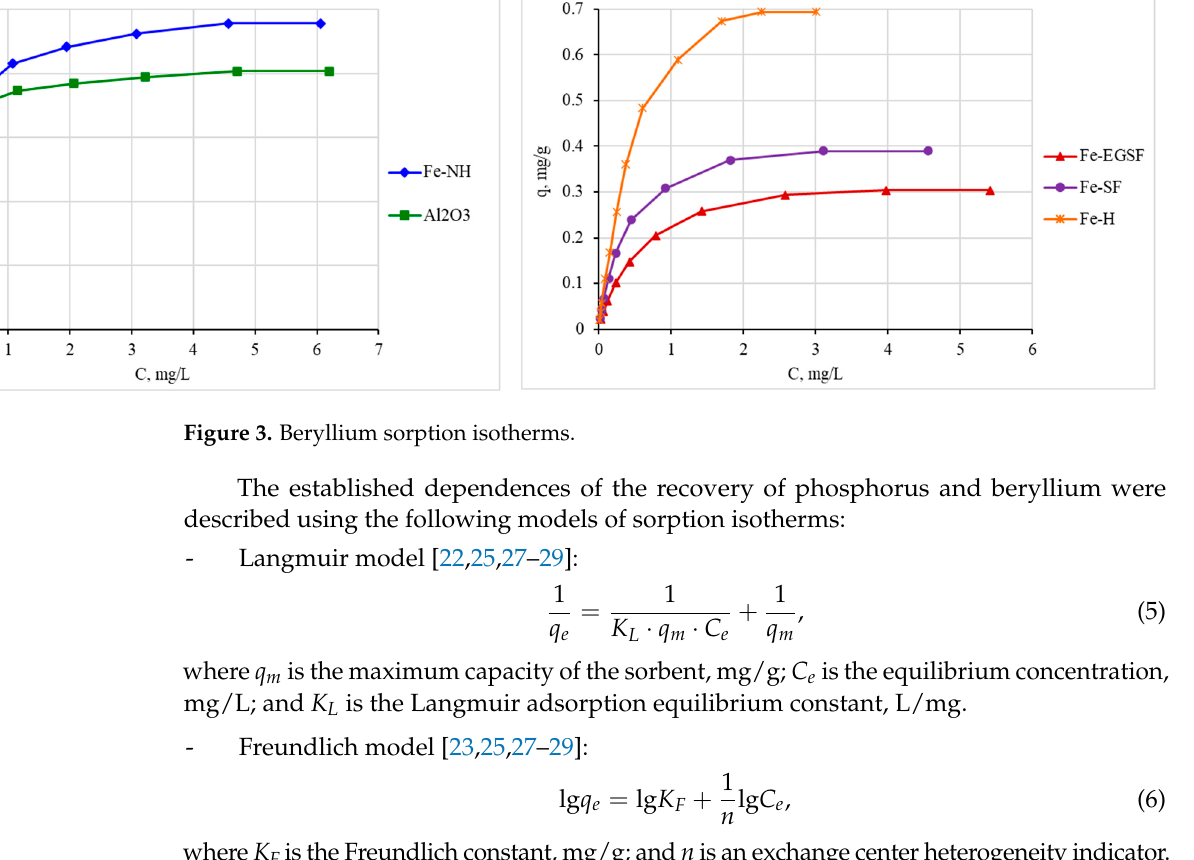
Figure 2. Phosphorus sorption isotherms.